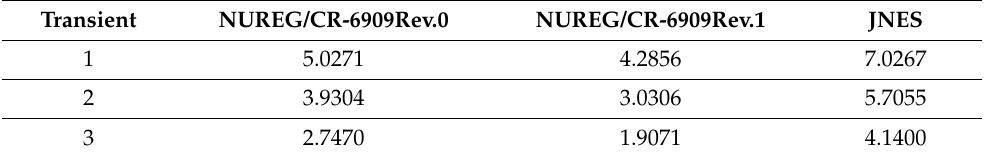
Table 4. Results of F en under different